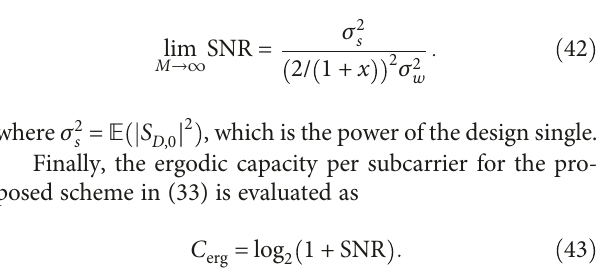
Figure 4: The polarization constellation comparison of the proposed scheme with and without phase noise. M = 500 , σ SNR = 1 5